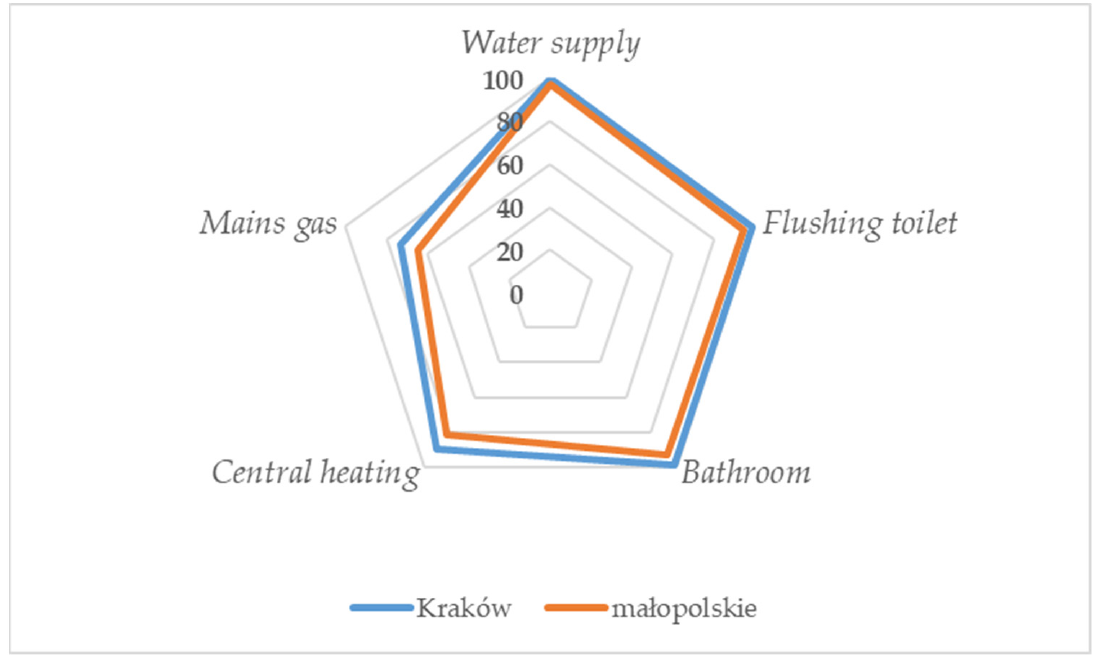
Figure 9. Indicators of housing infrastructure quality in Kraków and the Ma ł opolska Province.